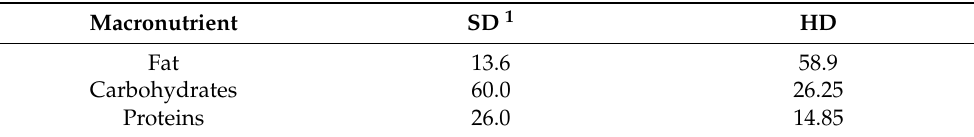
Table 4. Macronutrient distribution in standard (SD) and hypercaloric (HD)